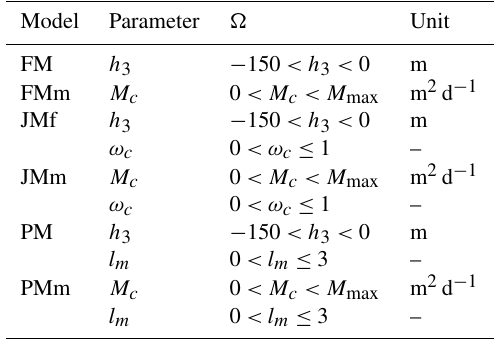
Table 4. Parameters of the root water uptake models estimated by optimization and their respective constraints (cid:127) .